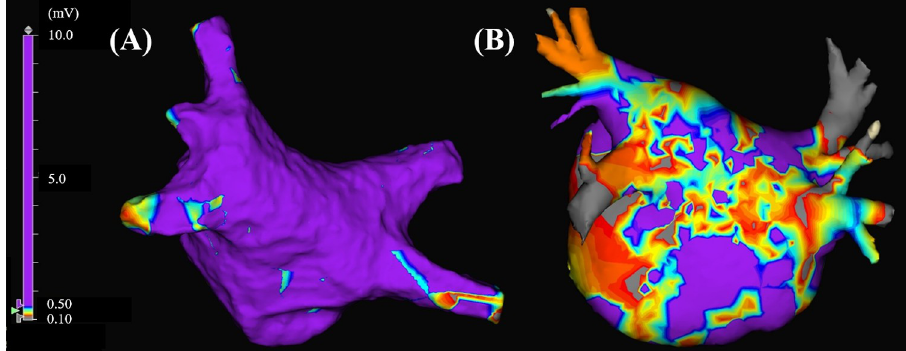
Fig 1. Examples of voltage maps of patients without (A) and with (B) low-voltage zones in the left atrium (posterior– anterior view).